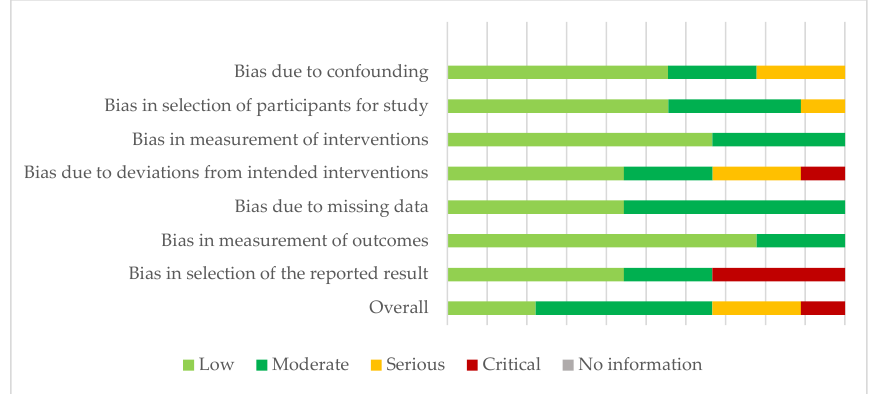
Figure 4. Risk of bias assessment in quasi-experimental studies (ROBINS-I).